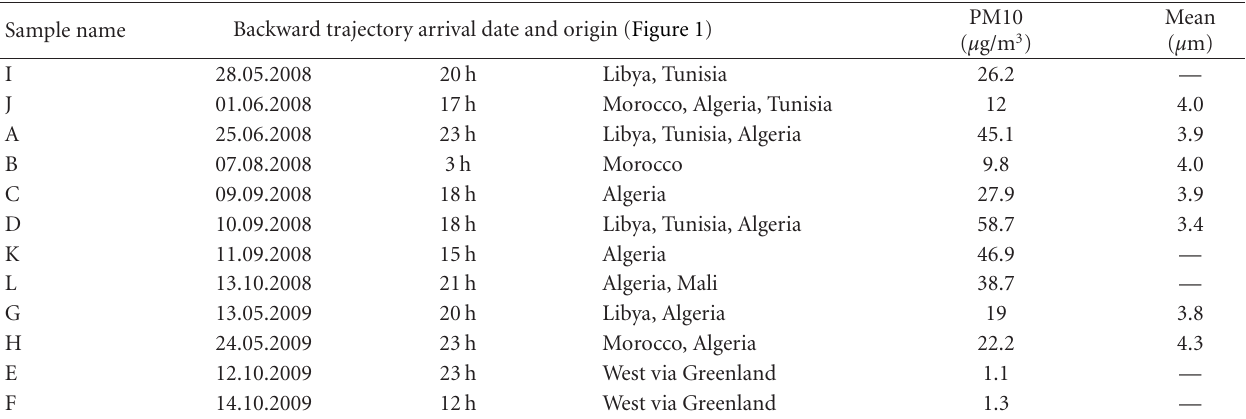
Table 3: The backward trajectory arrival date and source countries of the Sahara dust events collected at the Jungfraujoch (JFJ) Research Station, PM10 values and mean grain